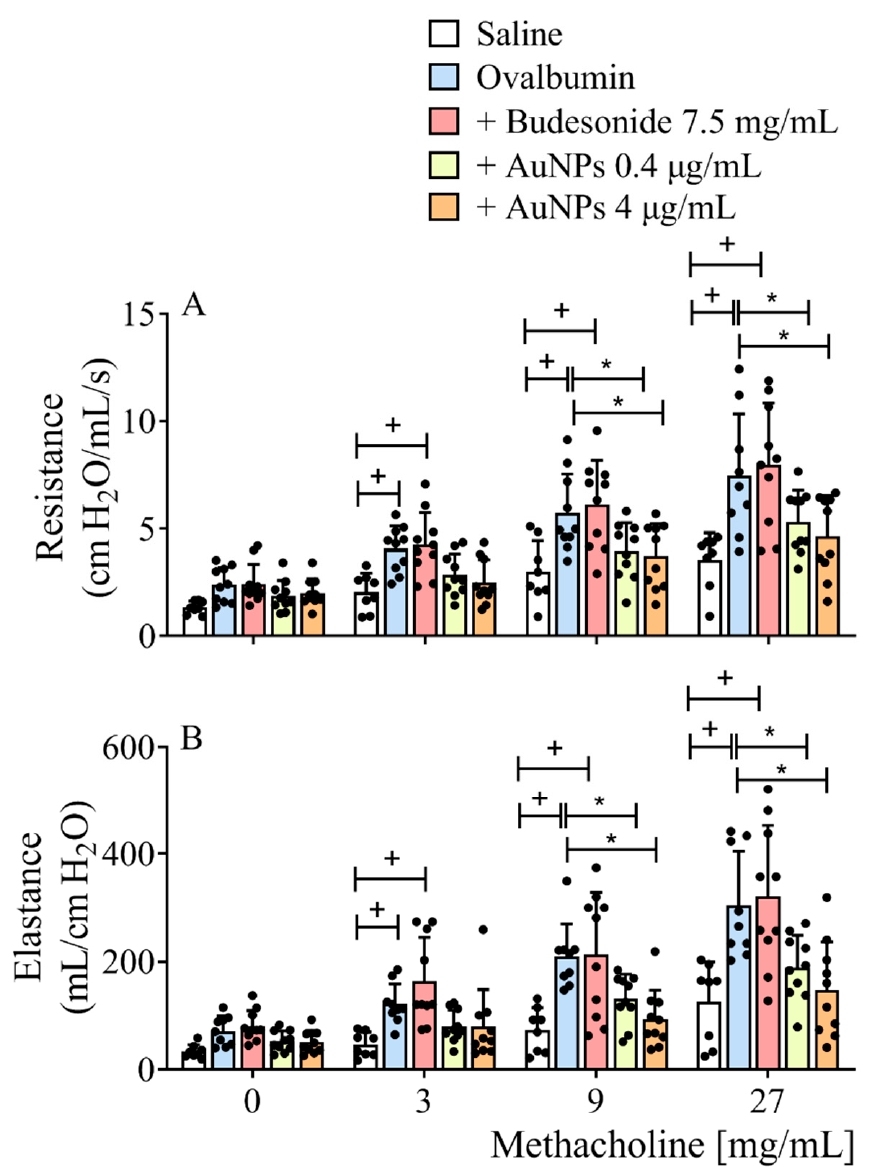
Figure 1. The effect of treatment with nebulized Budesonide or gold nanoparticles (AuNPs) on airway hyper-reactivity following the protocol of ovalbumin intranasal instillation given once a week for 9 weeks. The treatment was given 1 h before allergen provocation at weeks 3 to 9. Airway responsiveness was measured by changes in lung resistance and elastance induced by aerosolization of increasing concentrations of methacholine 24 h after the last antigen challenge. Data are expressed as mean ± SD (Each dot represents an individual mouse; n of at least 8 mice per group). + p < 0.05 as compared with the saline group, * p < 0.05 as compared with the ovalbumin-challenged